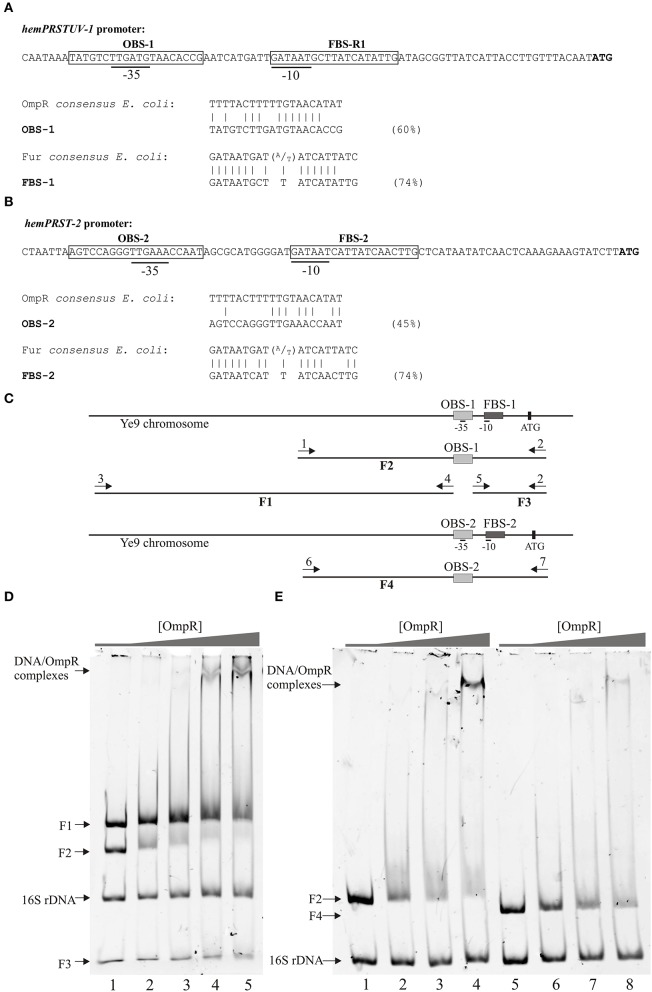
OmpR binding to fragments of the hem-1 and hem-2 promoter regions. (A,B) OmpR- and Fur-binding sites identified in promoter regions of the two heme uptake loci. The −35 and −10 promoter elements are underlined and putative regulator-binding sites are boxed. The ATG start codon of the first ORF of each operon is shown in bold. FBS, Fur-binding site; OBS, OmpR-binding site. (C) Schematic representation of fragments used in EMSA experiments presented in (D) and (E). The numbered arrows represent the primers used to amplify the DNA fragments used in EMSAs: 1, hem1F; 2, hem1R, 3, hem1-aF; 4, hem1-aR; 5, hem1-bF; 6, hem2F; 7, hem2R. (D) EMSA with fragment F2 (326 bp) containing OBS-1 and neighboring fragments F1 (415 bp, upstream) and F3 (107 bp, downstream). A 16S rDNA fragment (211 bp) was used as a negative control. The reaction mixtures contained 0.05 pmol of each fragment and increasing amounts of purified OmpR-His6 were added: lane 1, no protein; lanes 2–5, 0.65, 1.31, 2.61, and 3.92 μM of OmpR-His6, respectively. (E) Binding of purified OmpR-His6 to fragments containing OBS-1 (F2, lanes 1–4) and OBS-2 (F4, lanes 5–8). The 16S rDNA fragment was used as a negative control. The reaction mixtures contained 0.05 pmol of each fragment and increasing amounts of purified OmpR-His6 were added: lanes 1 and 5, no protein; lanes 2 and 6, 0.65 μM; lanes 3 and 7, 1.31 μM; lanes 4 and 8, 3.92 μM.